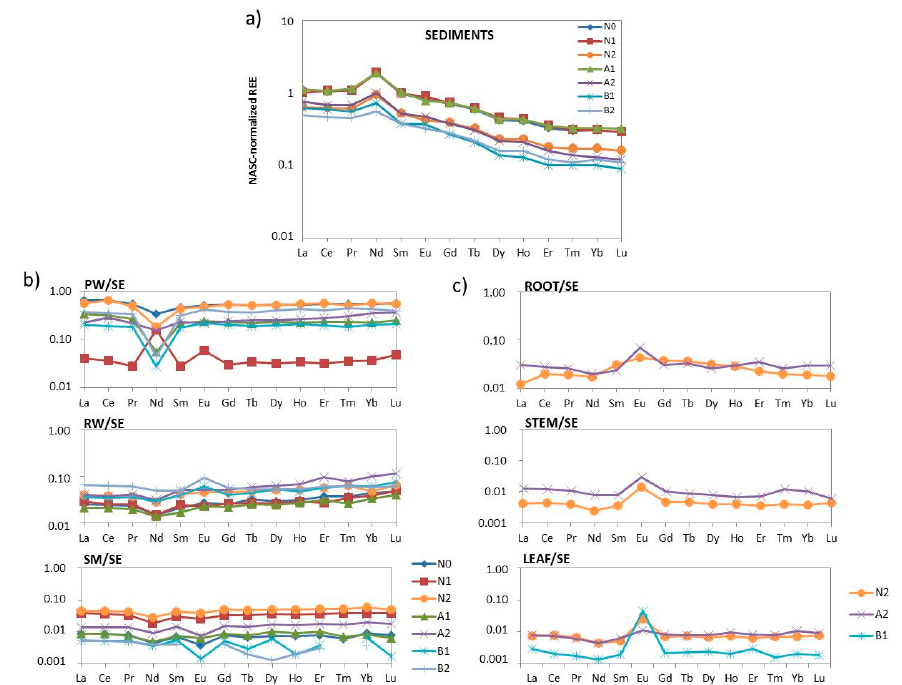
Figure 4. ( a ) NASC-normalized rare earth element (REE) patterns for the sediments (SEs); ( b ) REE patterns for sediment pore water (PW), river water (RW), and suspended material in rivers (SM) normalized to the respective sediment; ( c ) roots, stems, and leaves of REE patterns of the aquatic plant Typha latifolia L. (TY) normalized to the respective sediment. The total REE contents obtained for all studied fractions are shown in the Table S1.